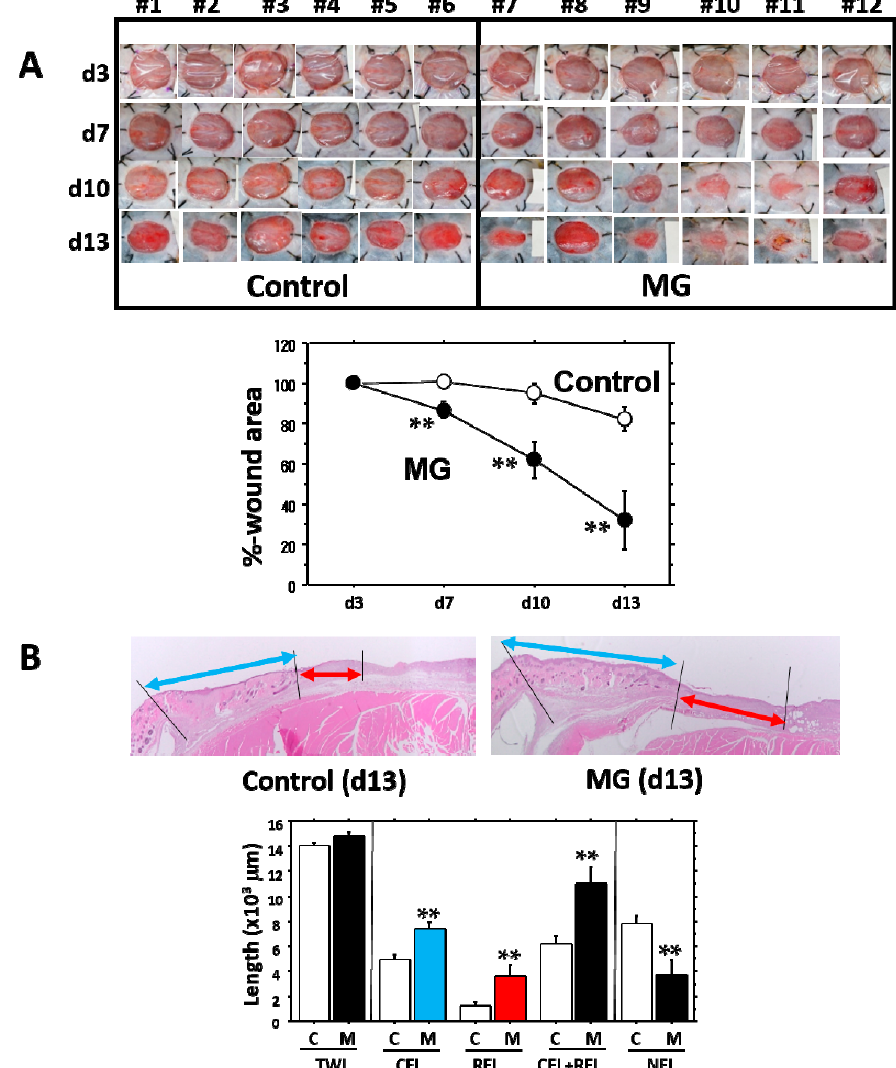
Figure 5. Change in wound area and histological parameters. During 13 days of the wound healing study, micrograft was performed on Day 3. ( A ) Entire wound pictures of individual mice are given. The graph shows the change of %-wound area during 13 days of the study; ( B ) The representative pictures of wound tissue 13 days after wounding in control and MG groups; epidermis shown by the blue line is in contractive healing, and epidermis shown by the red line is in regenerative healing. TWL: total wound length; CEL: contractive epithelial length; REL: regenerative epithelial length; NEL: non-epithelial length. Value: mean ± SE. **: p < 0.01.